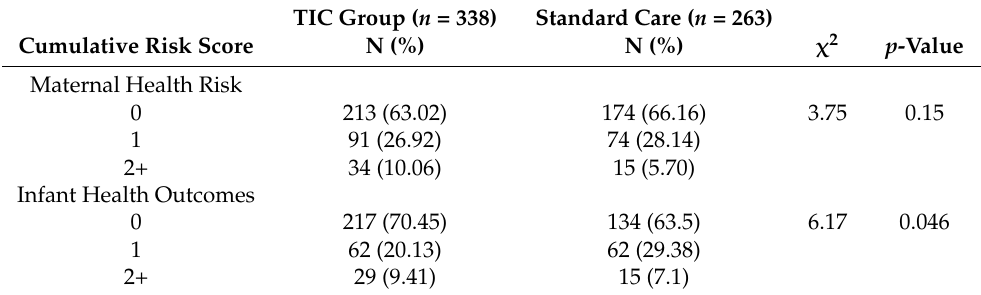
Table 2. Differences in Mean Cumulative Risk Scores for TIC versus Standard Care Groups. TIC Group ( n =